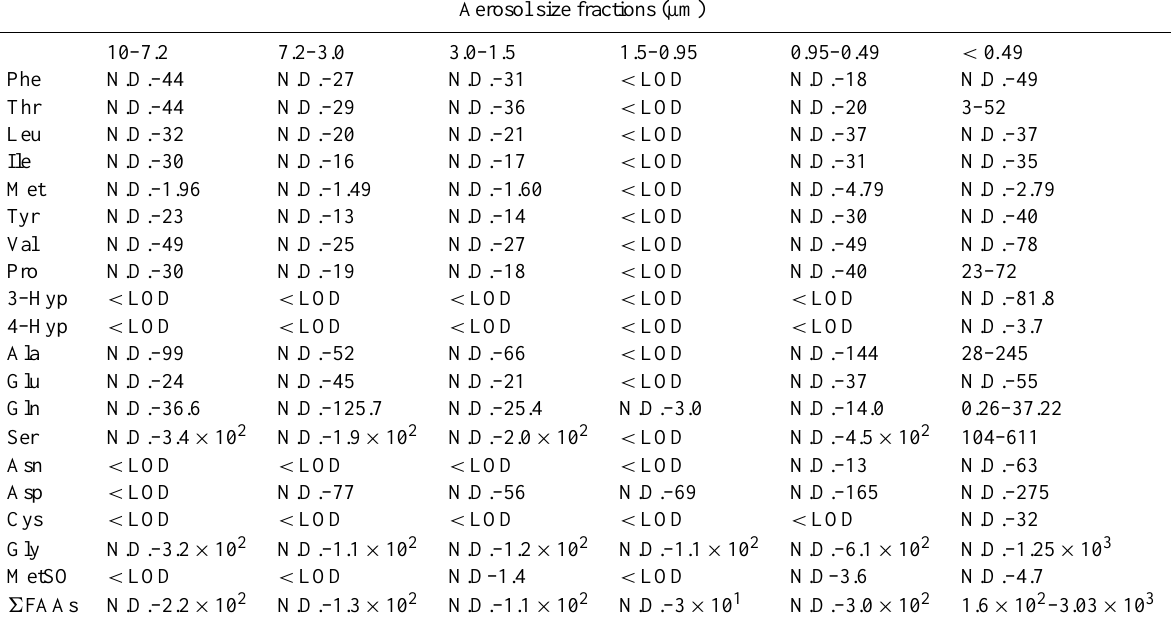
Table 2. Amino acid concentration ranges in the single stages of the completely analyzed samples (fmolm − 3